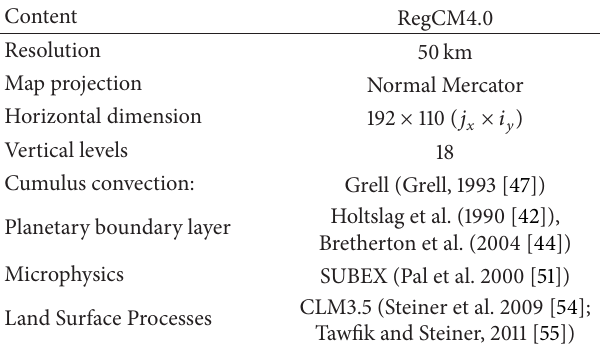
Table 1: Model configuration used in the study.